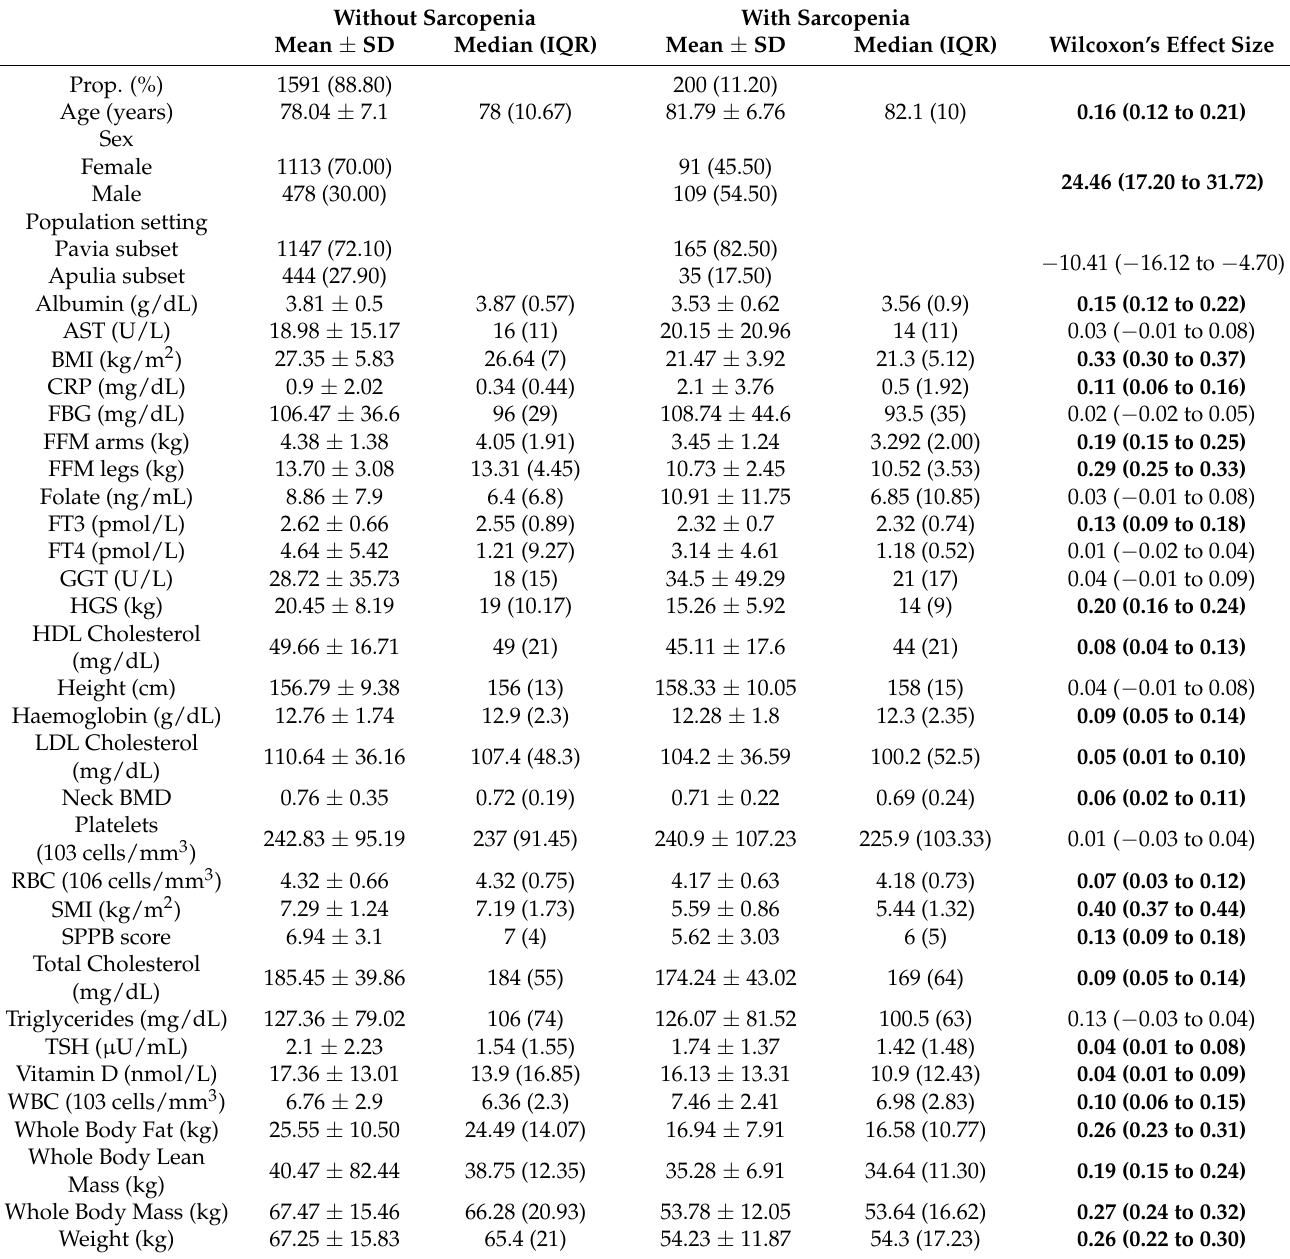
Table 2. Description of the whole sample by sarcopenia condition